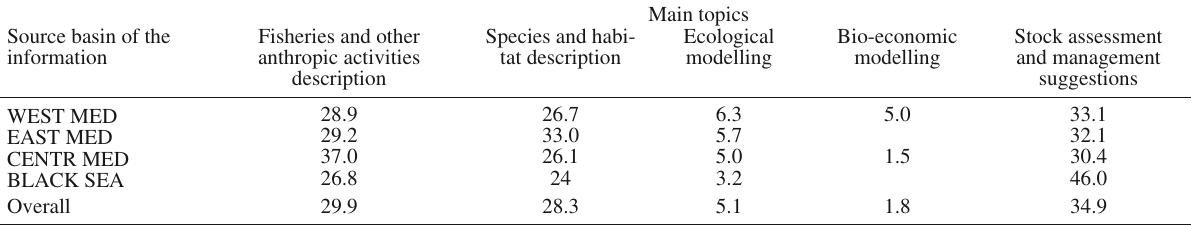
Table 4. – Classification of the information gathered according to the main topics of each activity. The values reported are the percentage contributions. The results are presented by main